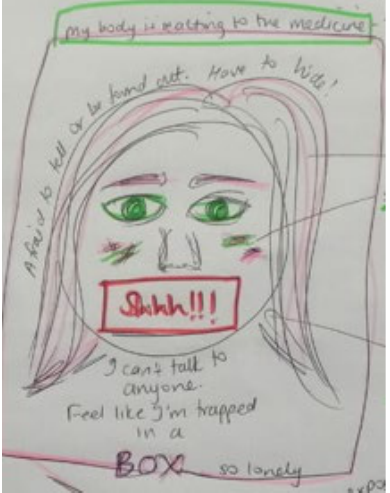
Figure 10: Bodily changes, internal stigma, and suicidal ideation